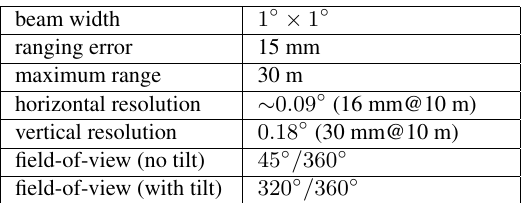
Table 1. MSS acquisition parameters